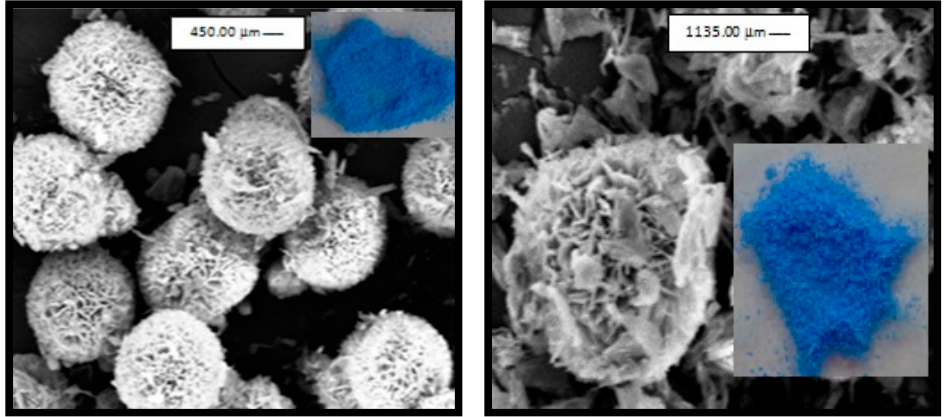
Figure 8. SEM images of nano-oligomer-containing copper complex with Glu in the presence of CTAB (10 − 2 M) ( left ) or PVA (10 − 5 M) ( right ).